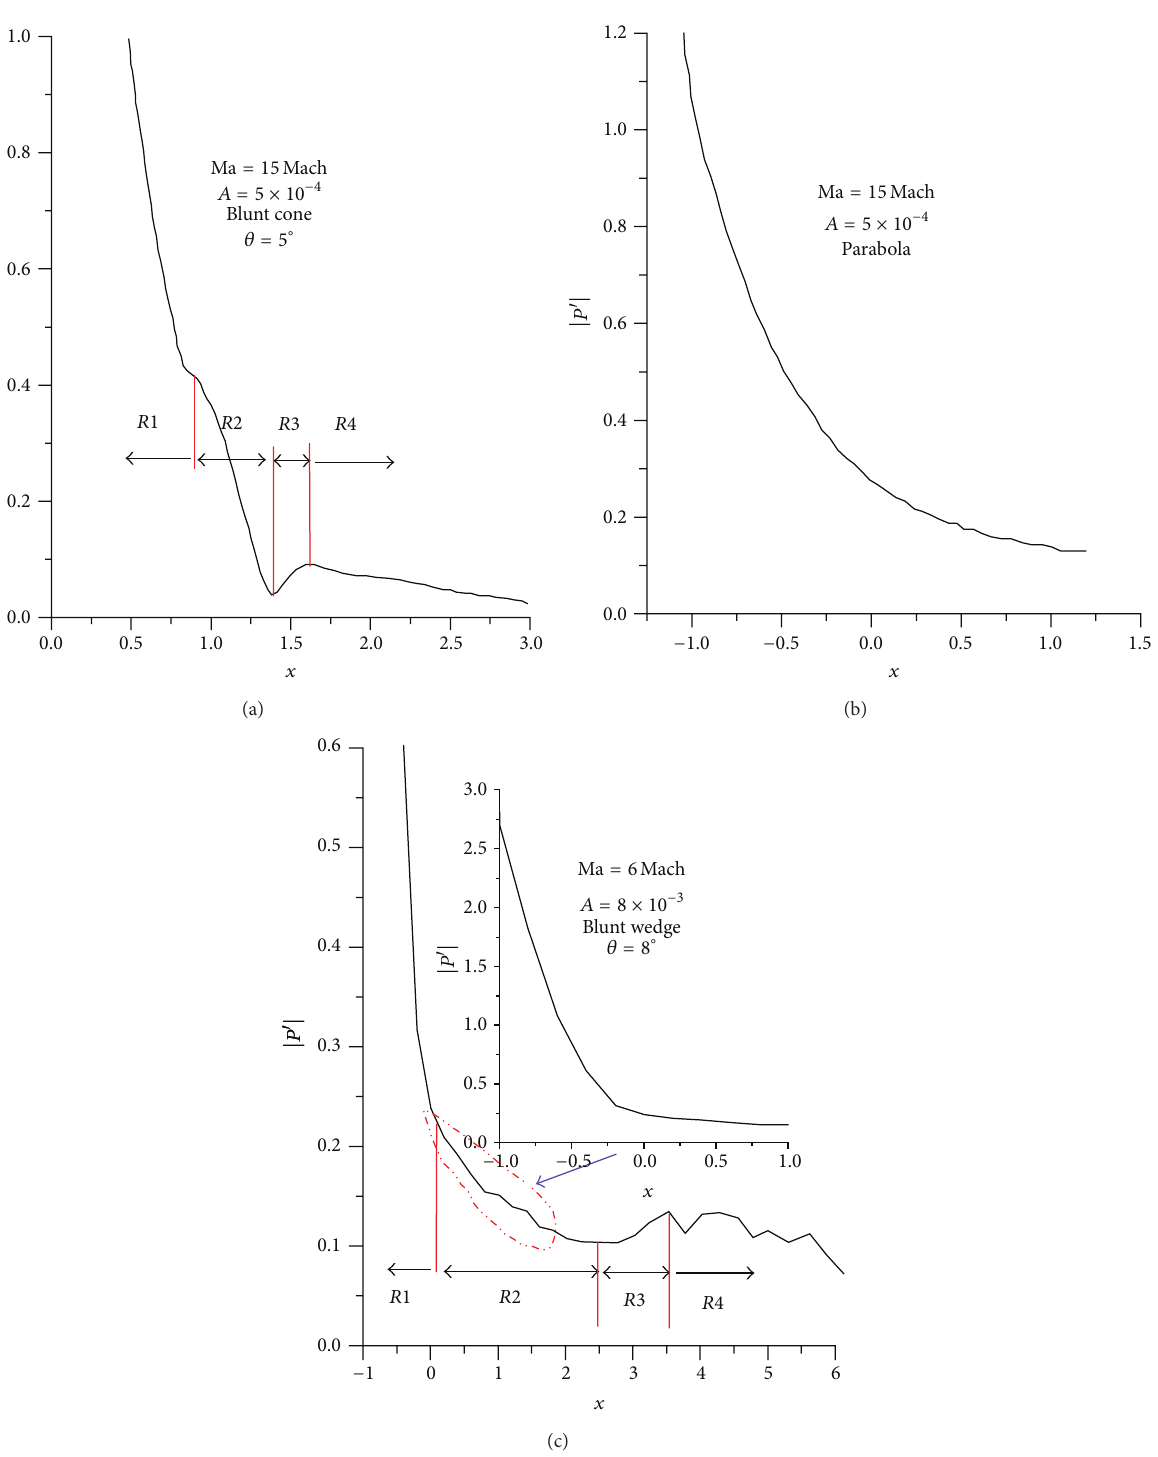
Figure 6: Fourier amplitudes of pressure disturbance in boundary layer are compared with literatures [21,